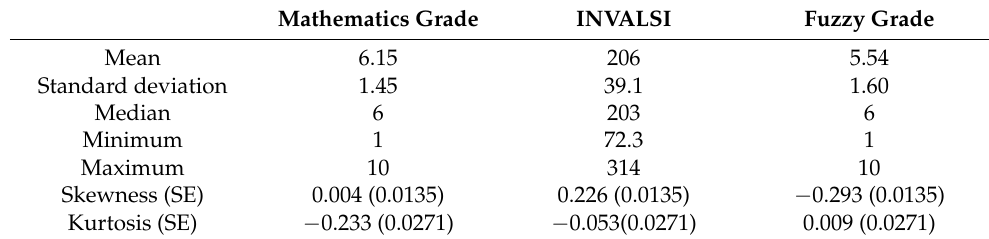
Table 9. Descriptive statistics for 10th grade students.